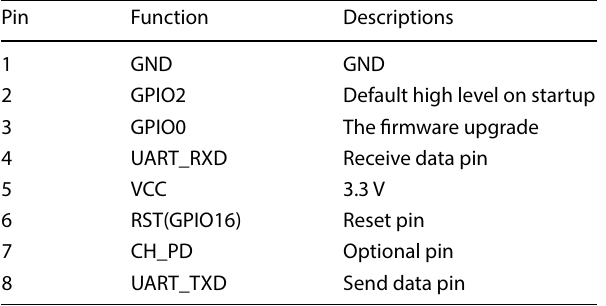
Table 1 ESP8266 wireless module pin